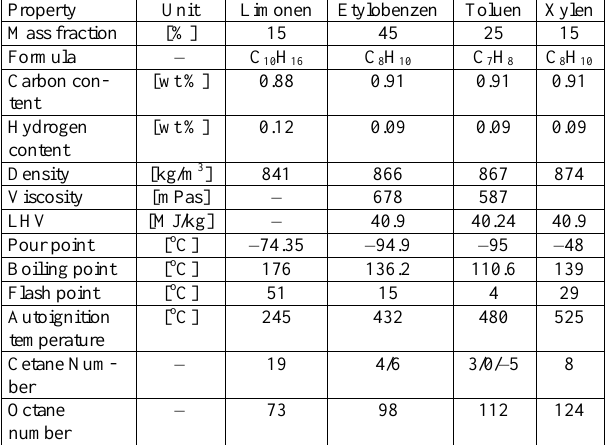
Table 5. Properties of compound of tire pyrolysis oil [13, 17]